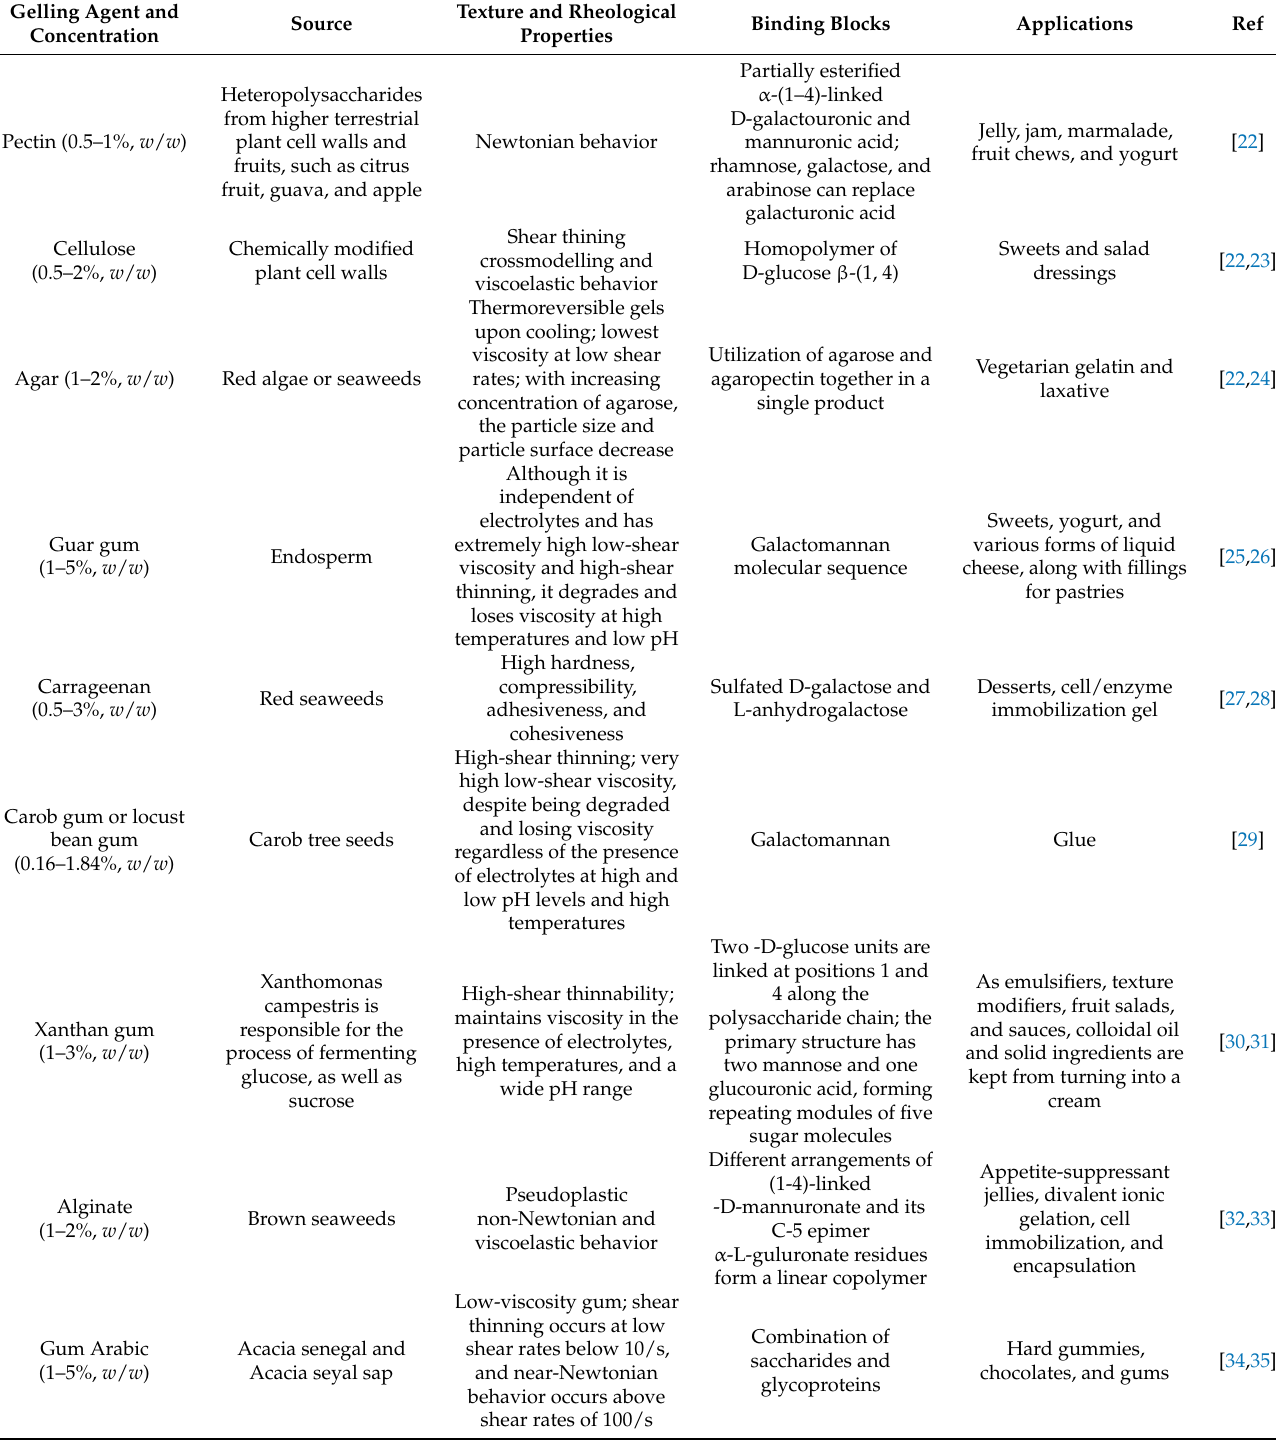
Table 1. Sources of gelling agents, as well as their textures, rheological properties, and